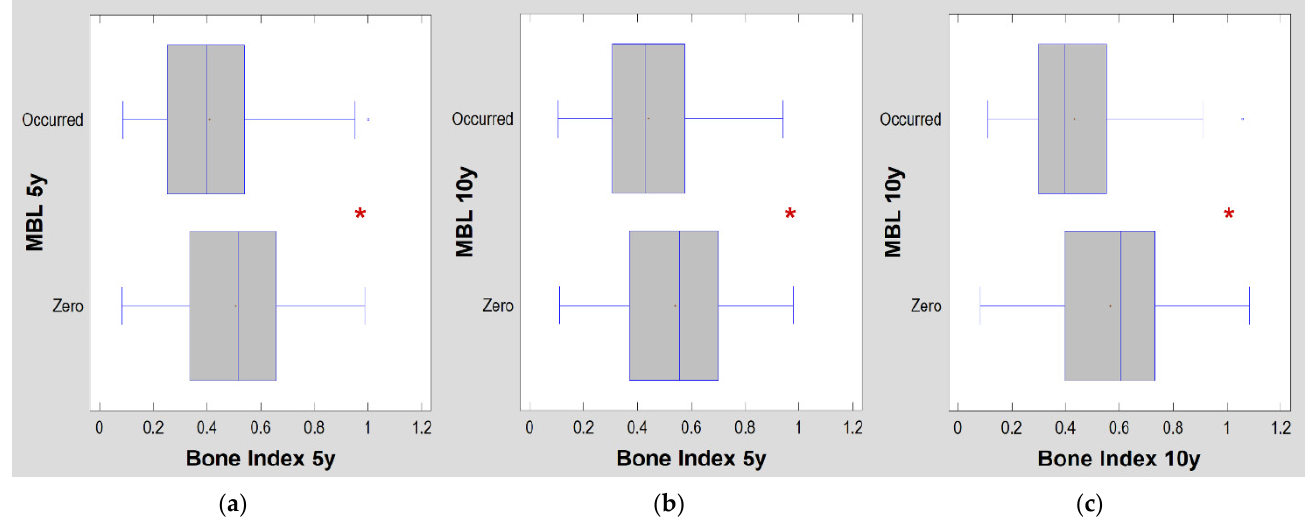
Figure 4. Relationship of crestal bone level to degree of corticalization. Due to the fact that the bone index is a measure of similarity to trabecular (cancellous) bone, therefore, the lower the bone index value, the more corticalized the bone is: ( a ) five-year observations for both variables; ( b ) five-year bone index compared to marginal bone loss noted at the ten-year examination, i.e., predicting whether marginal bone loss will occur after ten years if a given level of bone index value is observed in the fifth year of observation; ( c ) ten-year observations for both variables. The vertical lines in the boxes indicate the median value. Asterisks indicate statistically significant differences. All occurred at the p < 0.0001 level. MBL-marginal bone loss; 5y, 10y—five- and ten-year observations. Table 3. Peri-implant bone feature observed among examined implant designs in this study. Design